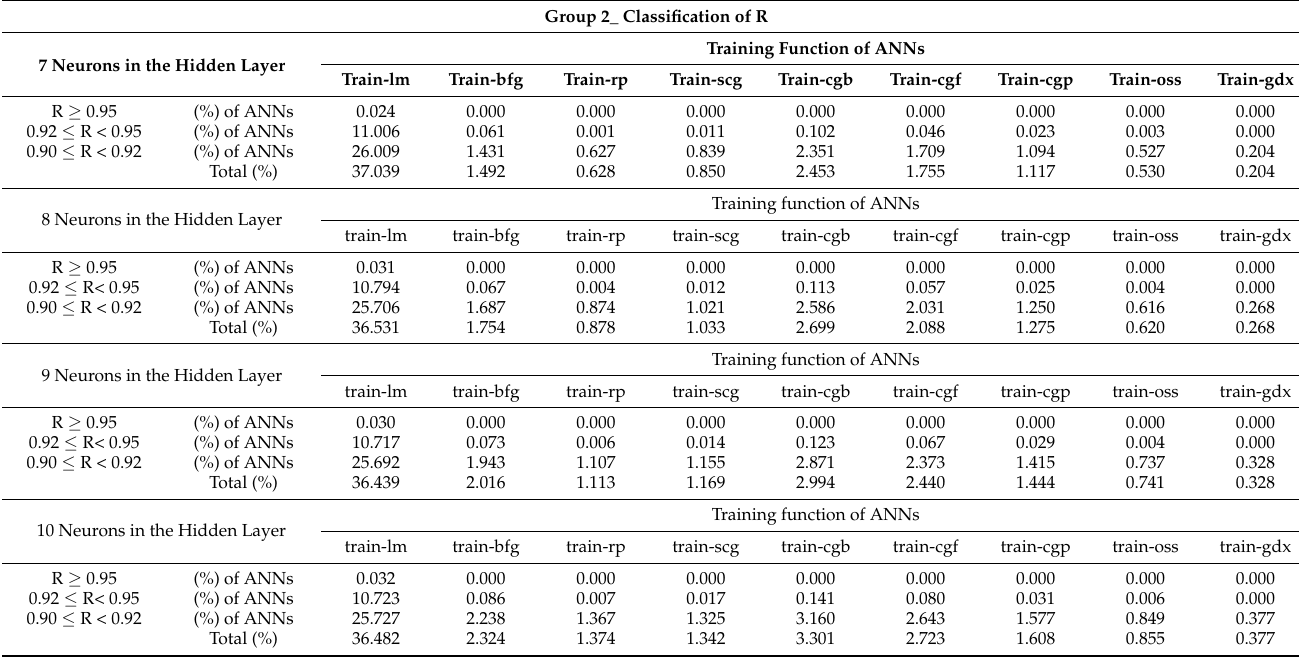
Table 10. Classification of R—ANNs with input parameters of Group